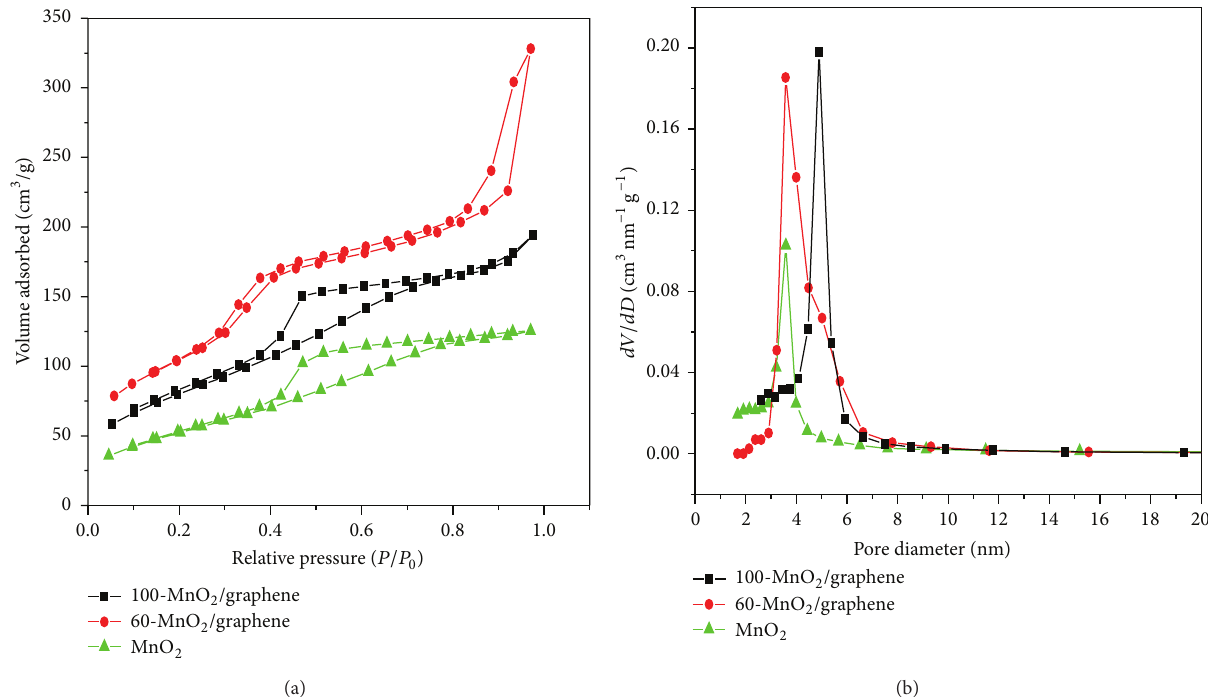
Figure 7: N 2 adsorption-desorption isotherms (a). Pore size distributions calculated by BJH